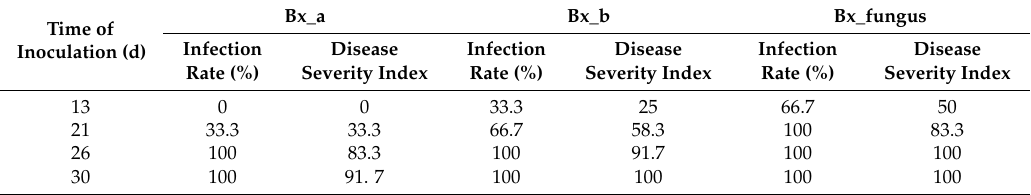
Table 1. Symptoms of P. massoniana caused by aseptic B. xylophilus , B. xylophilus treated with S. maltophilia NSPmBx03, and fungus B. xylophilus . Bx_a: aseptic B. xylophilus , Bx_b: B. xylophilus